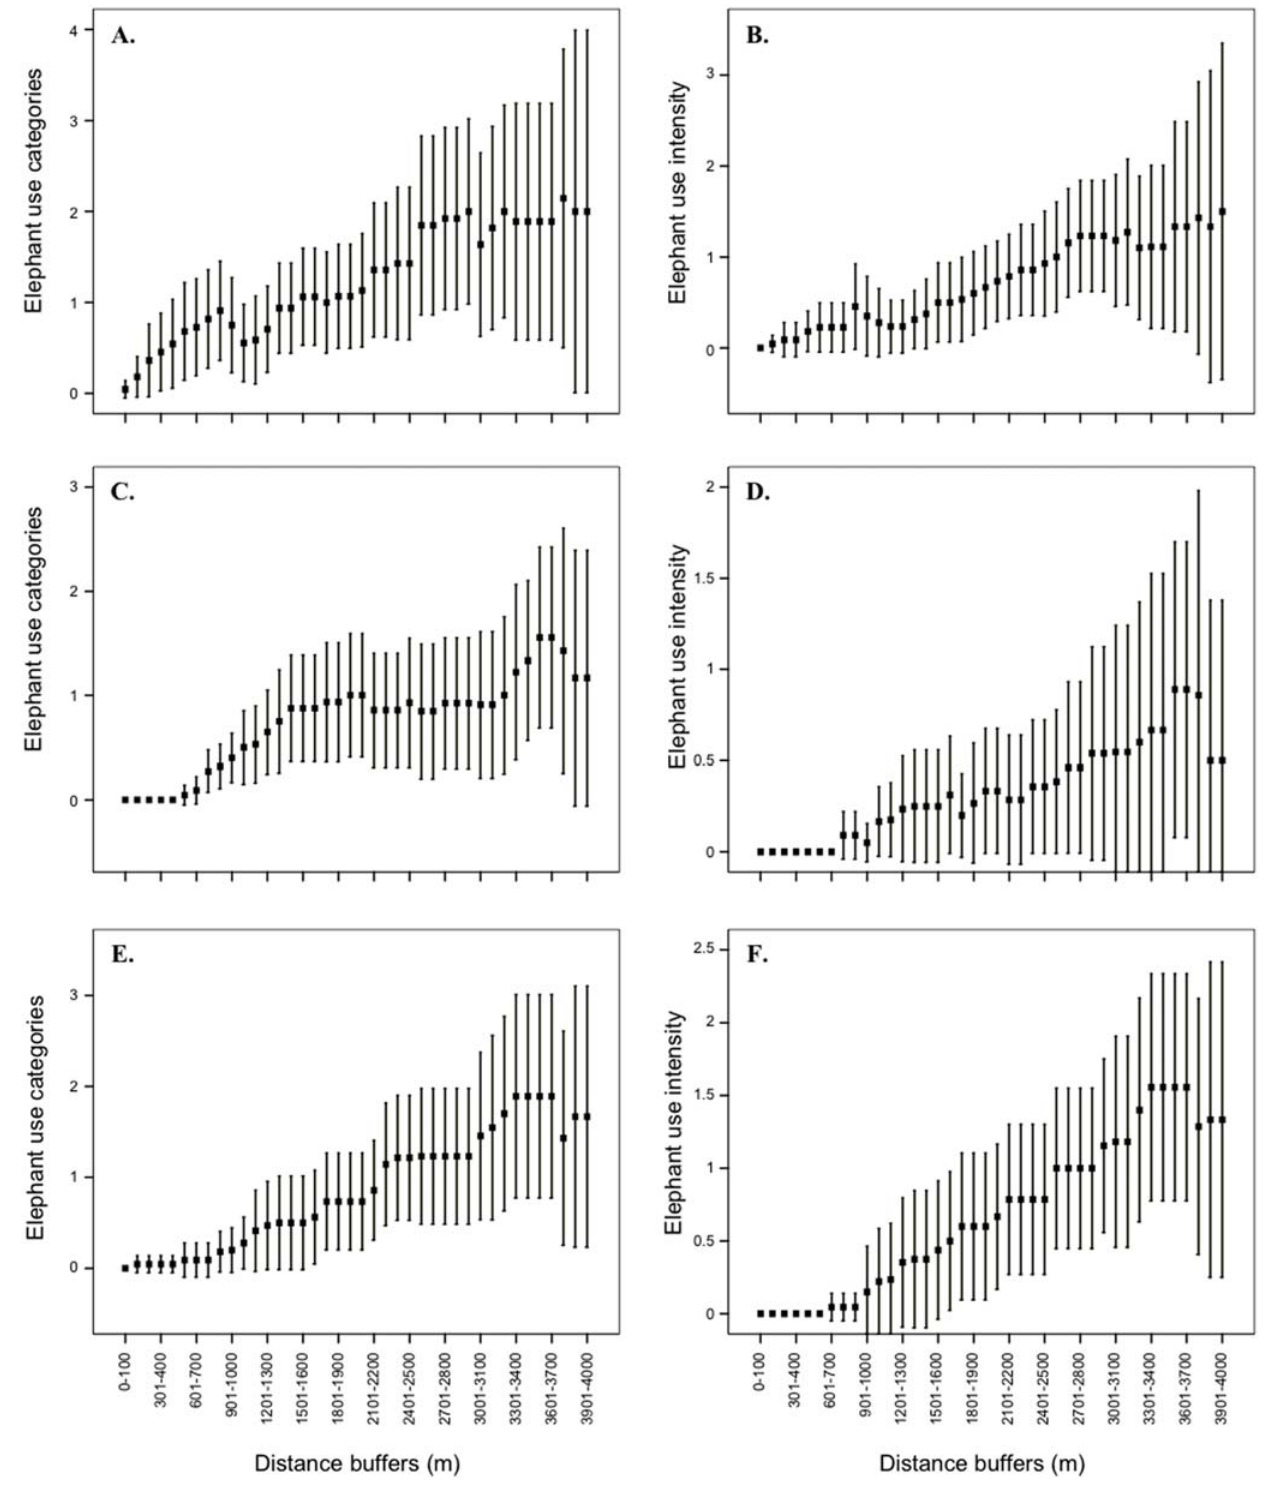
Figure 2. Accumulation curves (mean 6 95% confidence limits) within increasing 100 m buffers to determine optimal distance (observed as the point at which the dependent variable levels off) required to sample elephant (a) use categories and (b) intensity of use categories for Acacianigrescens , (c) elephant use categories and (d) intensity of use categories for Combretumapiculatum and (e) elephant use categories and (f) intensity of use categories for Sclerocarya birrea . Note the greater variation for single species accumulation curves (compared with Fig. 1) and the increased distance required to approach an optimal transect length.